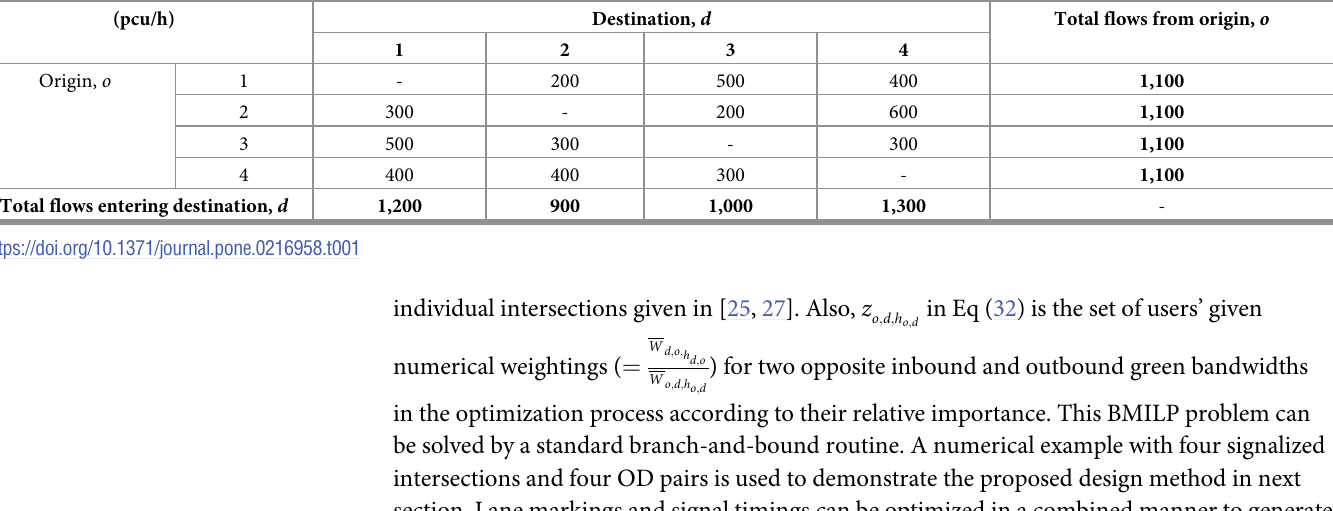
Table 1. Demand OD